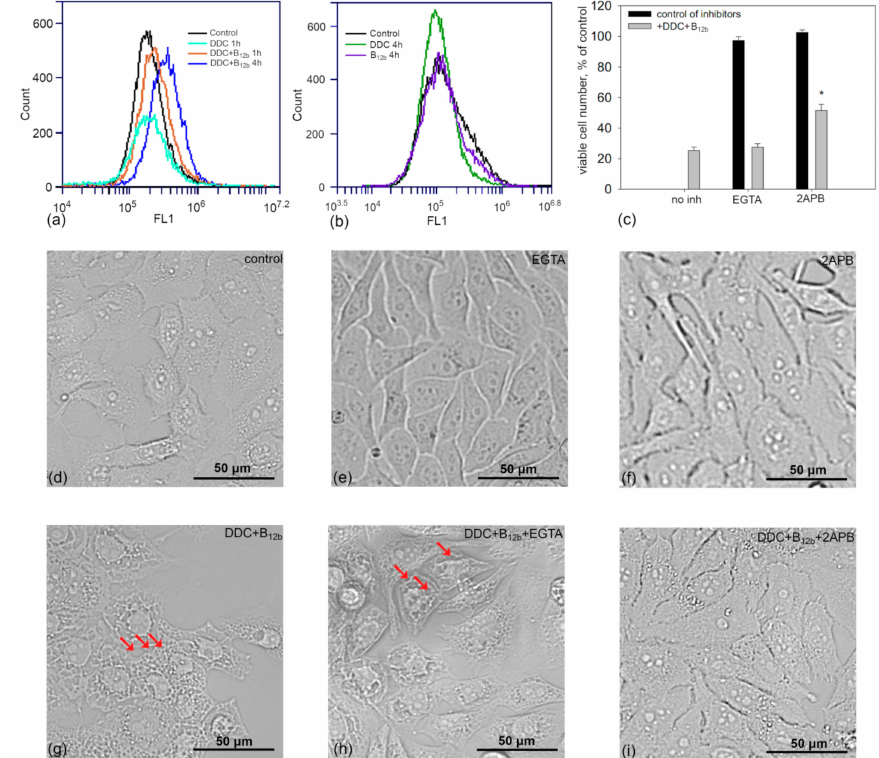
Figure 11. Increase in the concentration of intracellular Ca 2 + during the initiation of cell death by the combination of 1 mM DDC + 25 µ M B 12b and the e ff ect of the inhibitor of IP3 receptor and chelator of extracellular calcium on the cytotoxicity of the combination. ( a ) and ( b ) FL1 fluorescence of cells stained with 5 µ M Fluo-4AM after incubation with DDC and B 12b . ( c ) E ff ect of the IP3 receptor inhibitor and EGTA on the initiation of cell death by the combination DDC + B 12b and cell vacuolization ( d – i ). Cells were incubated in growth medium for 90 min with 20 µ M 2-APB or with 2.5 mM EGTA, then DDC + B 12b was added, and after 6-h incubation, medium was replaced by a fresh growth medium without additives. Cytotoxicity was estimated 48 h after the treatment as compared with the control. *, p < 0.05, compared to cells treated with DDC + B 12b . The vacuolization of HEp-2 cells was estimated 6 h after the addition of DDC + B 12b (bright field). Control ( d ), 2.5 mM EGTA ( e ), 20 µ M 2-APB ( f ); DDC + B 12b ( g ), EGTA + DDC + B 12b ( h ), and 2-APB + DDC + B 12b ( i ). The arrows indicate